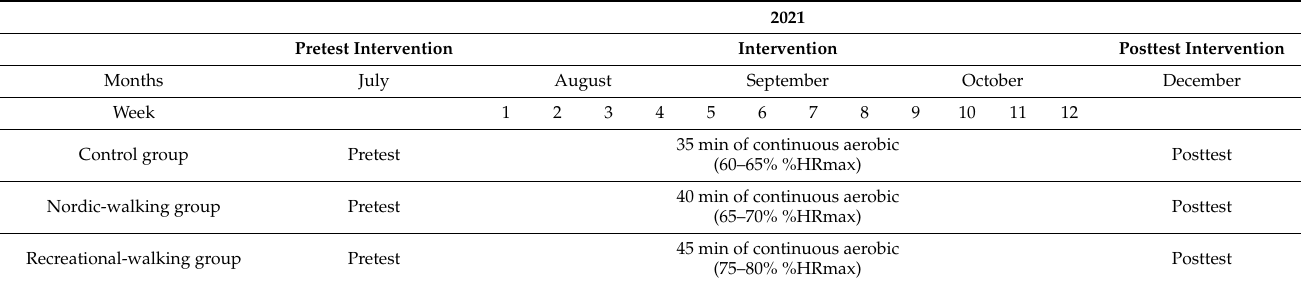
Table 1. Timeline of the